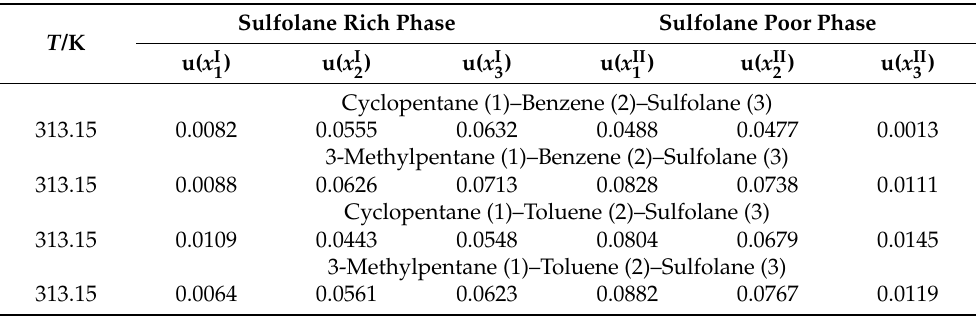
Table 2. The standard uncertainties of compositions for non-aromatics (1)–aromatics (2)–sulfolane (3) ternary systems at 313.15 K under 101.3